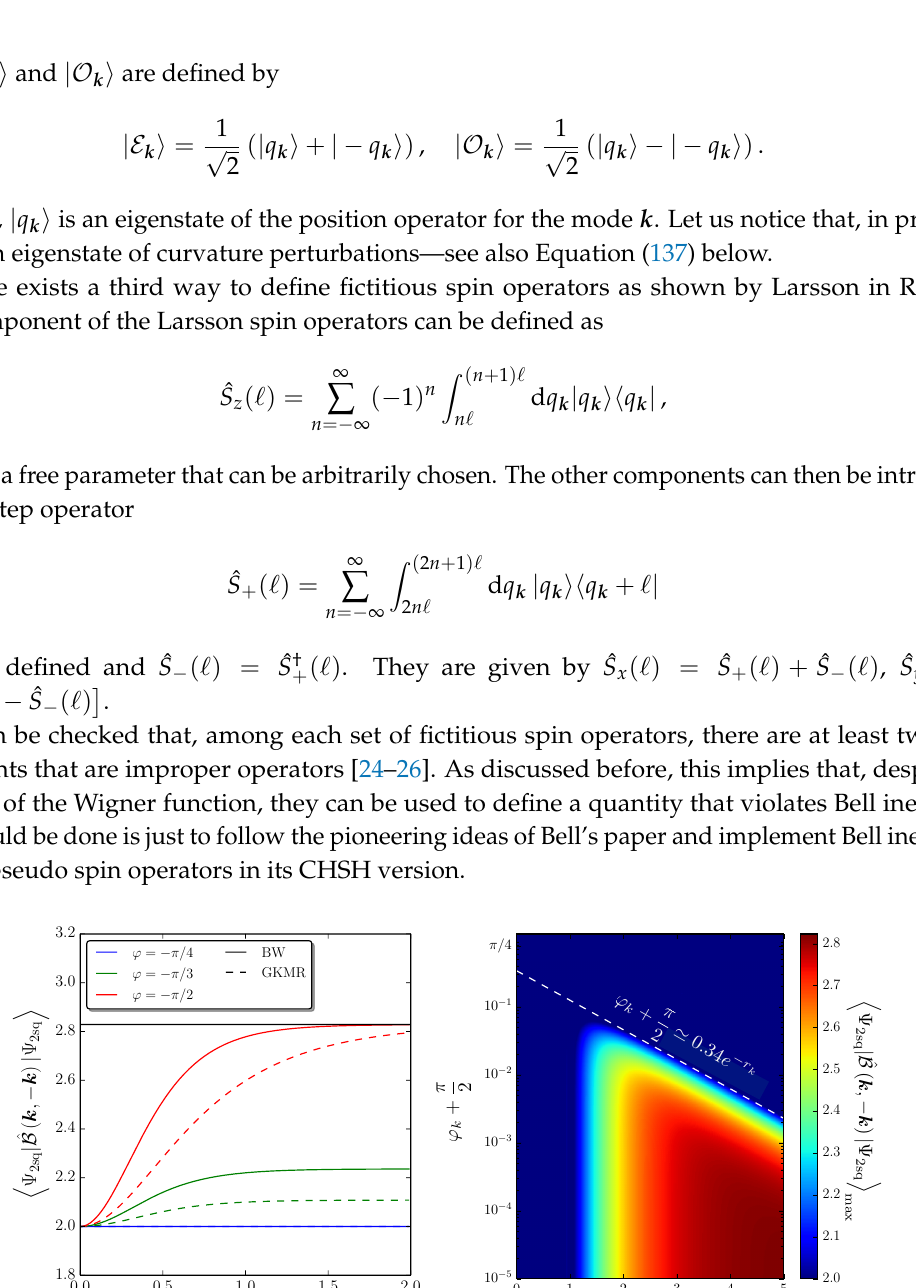
Ψ Ψ ˆ ( k , k ) 2sq | 2sq (cid:105)| ≥ 2. ( Right panel ): |(cid:104) B − |